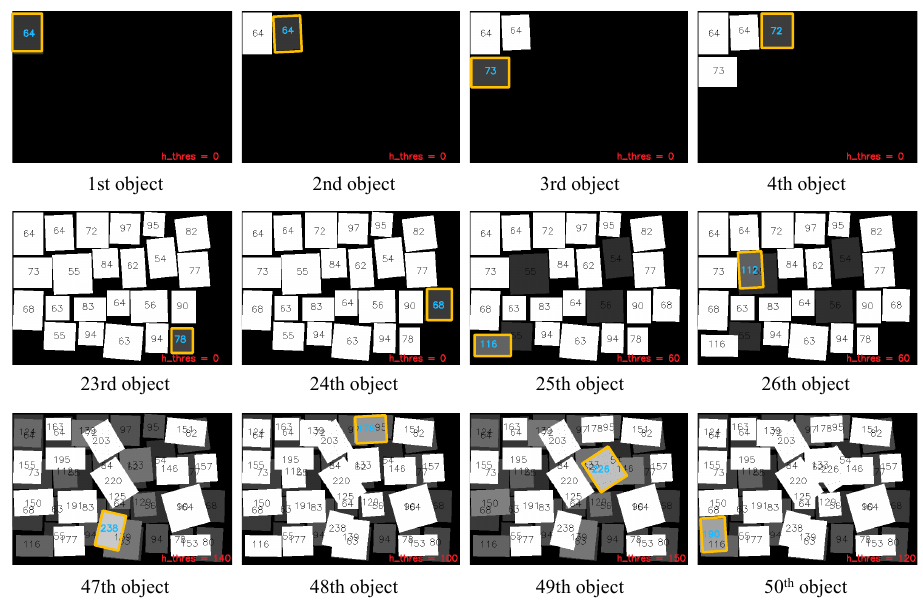
Figure 6. The snap shots of the object-packing simulation with manipulation error (position error of [ − 3, 3] mm, orientation error of [ − 3, 3]° and object boundary margin of 5